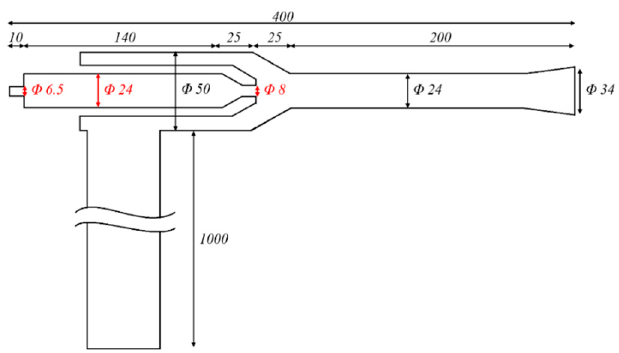
Figure 4. Schematics of a hybrid airlift-jet pump (units: mm; red-colored numbers and symbols present dimensions of a nozzle). Table 1. Geometry dimensions of a hybrid airlift-jet pump (units: mm).